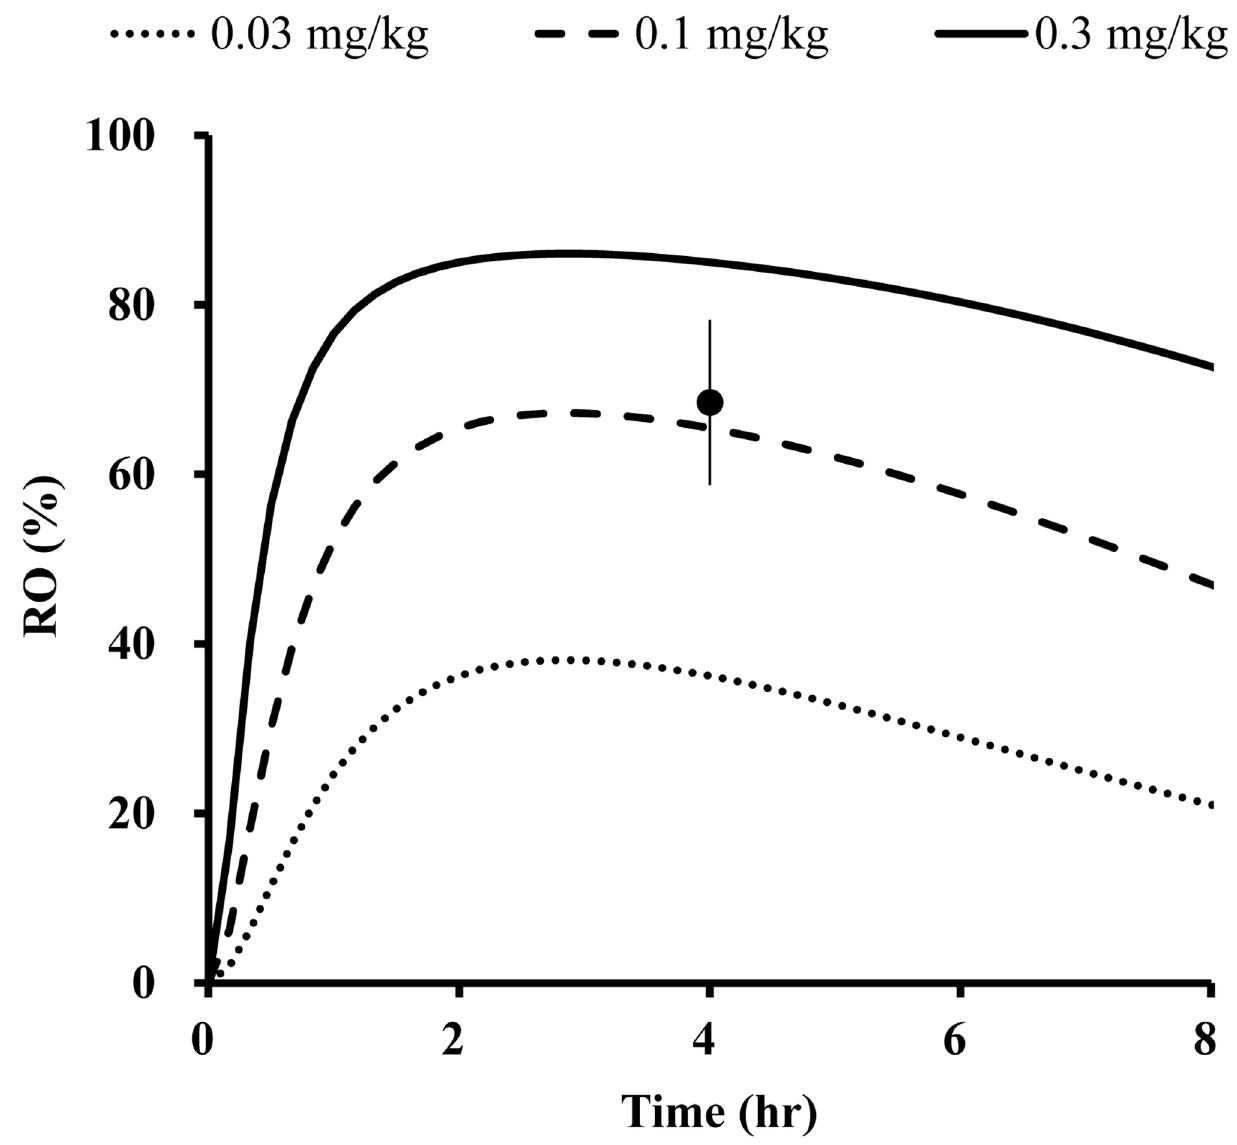
Figure 8. Effect compartment model estimation of 5-HT and 0.3 mg/kg to female rats. Solid circle and error bars represent mean RO ± S.E.M measured by PET scans in female rats (n = 3).